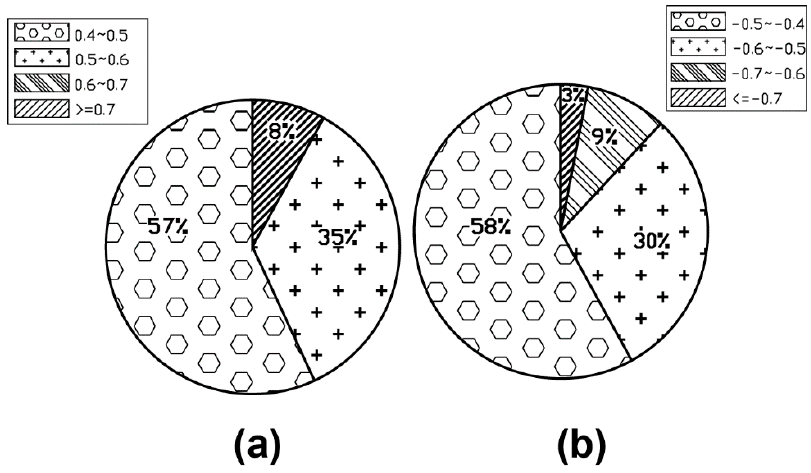
Table 4. Counts of flow velocity events. Figure 12. Statistical analysis of flow events. All flow events (amplitude more than 0.4 m/s) are counted: ( a ) the distribution of inflow events, and ( b ) the distribution of outflow events.